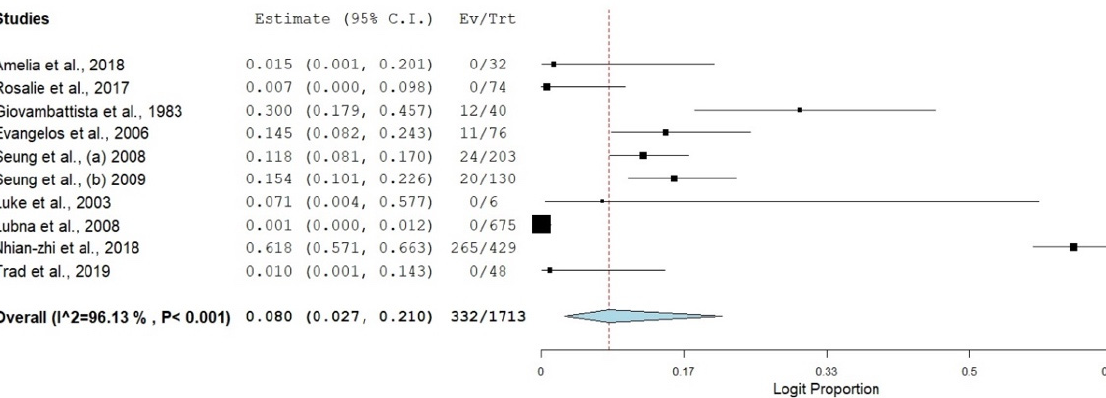
Figure 3. Forest plot showing SBP in HBV cirrhosis [17–26].